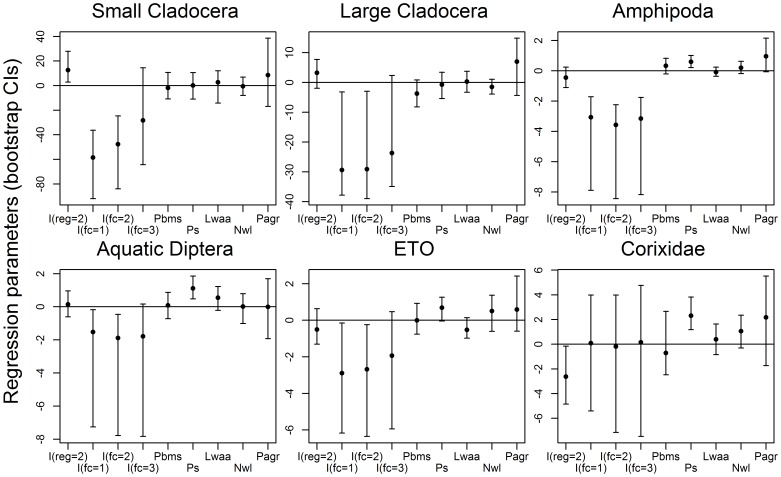
Confidence intervals for parameter estimates from regression models of invertebrate variables.Percentile-based 95% bootstrap confidence intervals for regression parameters associated with each of six invertebrate response variables: small cladocerans, large cladocerans, Amphipoda, Diptera, ETO = Emphemeroptera+Trichoptera+Odonata, Corixidae. For each response, the following predictors were included in the model: I(reg = 2) = an indicator variable equal to 1 if the lake is in the Parkland region and 0 if from the Prairie region [reference level]), I(fc = i) = an indicator variable equal to 1 if fish class = i and 0 otherwise (for i = 1, 2, 3), Pbms = planktivore+benthivore biomass (log transformed), Ps = submerged plant score, Lwaa = surface area of upstream lake watershed, Nwl = distance to the nearest permanent wetland or lake, Pagr = proportion agriculture within the upstream lake watershed. See Methods for additional details.